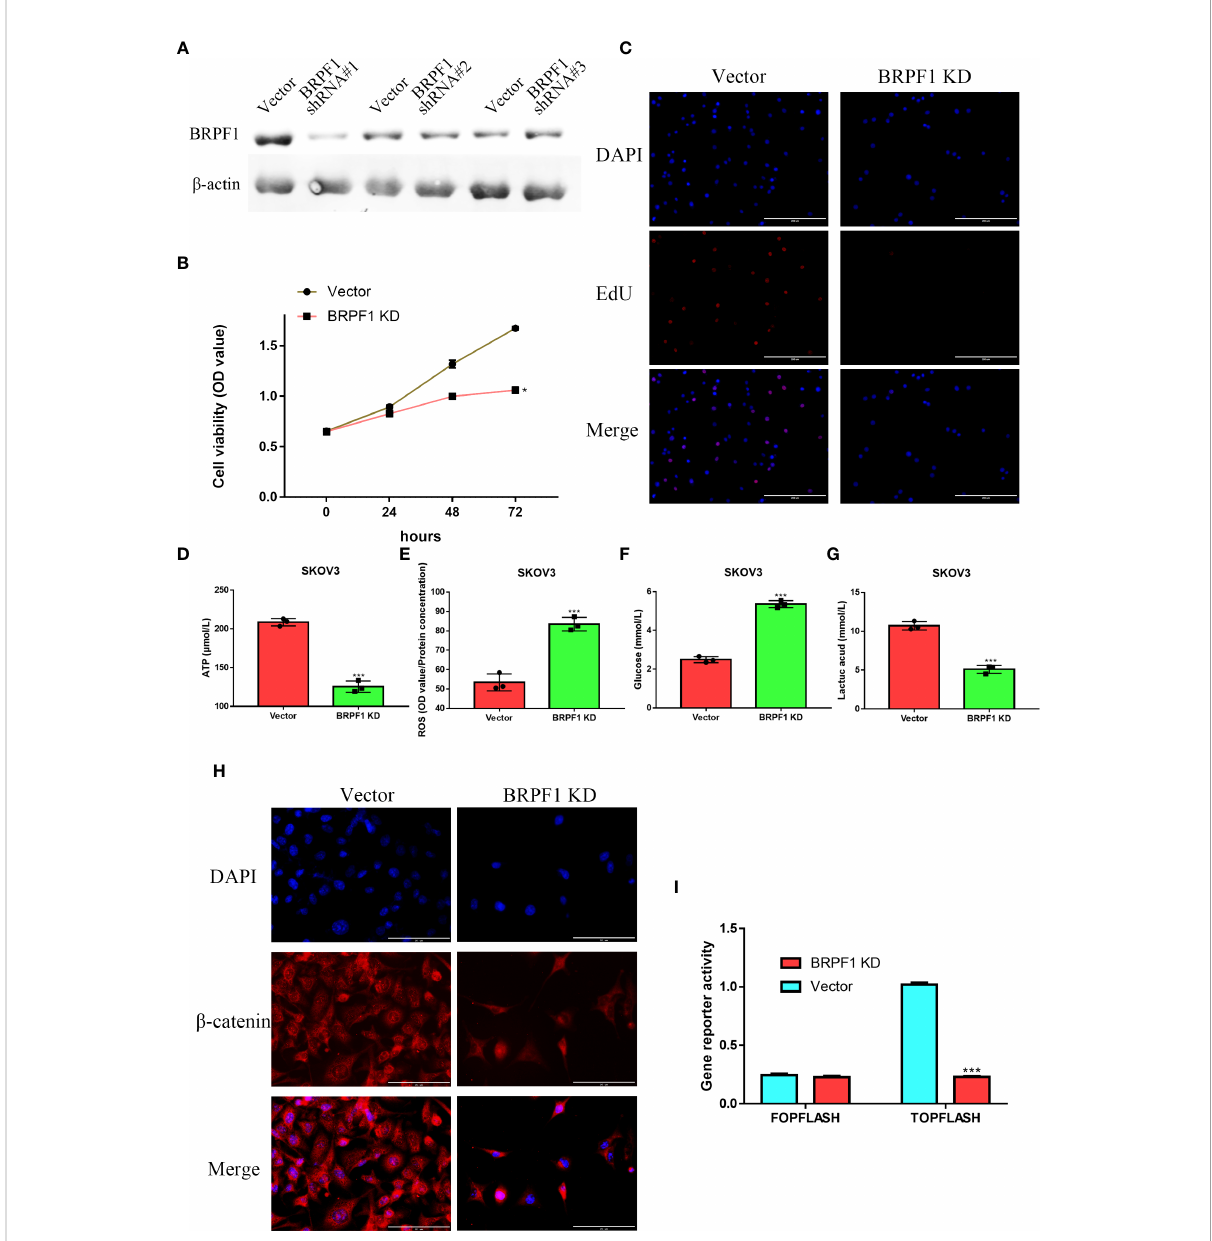
FIGURE 12 The effect of BRPF1 inhibition in SKOV3 cell lines (A) The effects of BRPF1 shRNA#1/2/3 on SKOV3 cell lines. (B) The effect of BRPF1 knockdown on the viability of SKOV3 cells by MTT assay. (C) The effect of BRPF1 inhibition on SKOV3 cell proliferation by EdU analysis. (D) The effect of BRPF1 inhibition on SKOV3 cell ATP production. (E) The effect of BRPF1 inhibition on SKOV3 cell ROS production. (F) The effect of BRPF1 inhibition on SKOV3 cell glucose consumption. (G) The effect of BRPF1 inhibition on SKOV3 cell lactic acid production. (H) The effect of BRPF1 knockdown on the lOSCation of b -catenin. (I) The effect of BRPF1 knockdown on Wnt pathway activity by a dual-luciferase reporter. *p < 0.05; ***p <